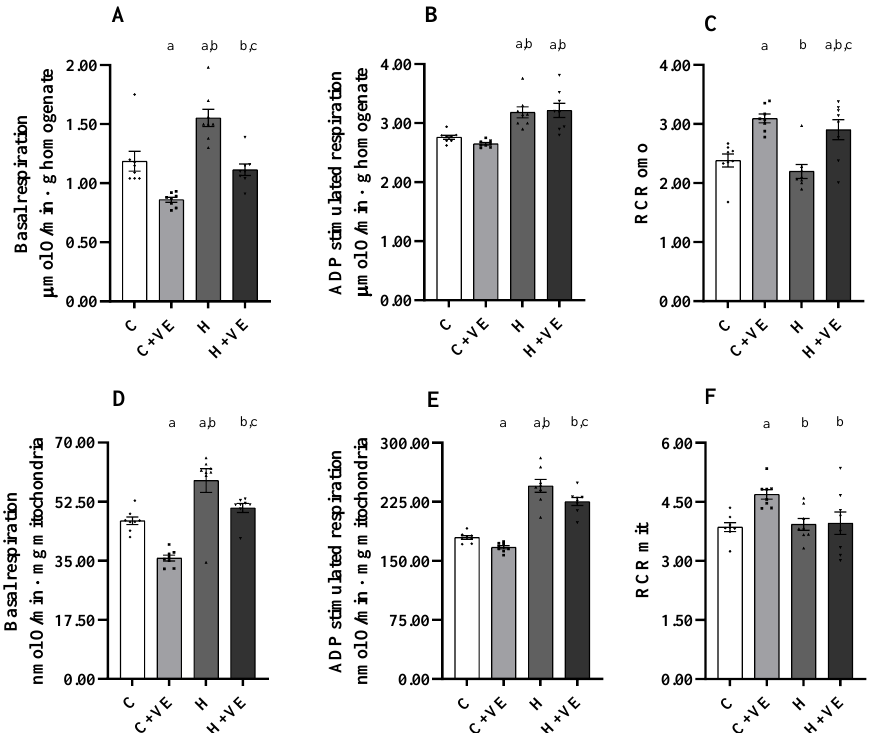
Figure 5. Basal and ADP-stimulated respiration and respiratory control ratio (RCR) detected in pyruvate plus malate supplemented homogenate ( A – C ) and mitochondria ( D – F ). C control rats; C + VE, vitamin-E-fed rats; H hyperthyroid rats; H + VE hyperthyroid and vitamin-E-fed rats. Values are the means ± SEM of eight different rats. p < 0.05 was chosen as the significance level. Meaning of the letters: a, p < 0.05 vs. C; b, p < 0.05 vs. C + VE; c. p < 0.05 vs. H (one-way ANOVA followed by Tukey post-test).